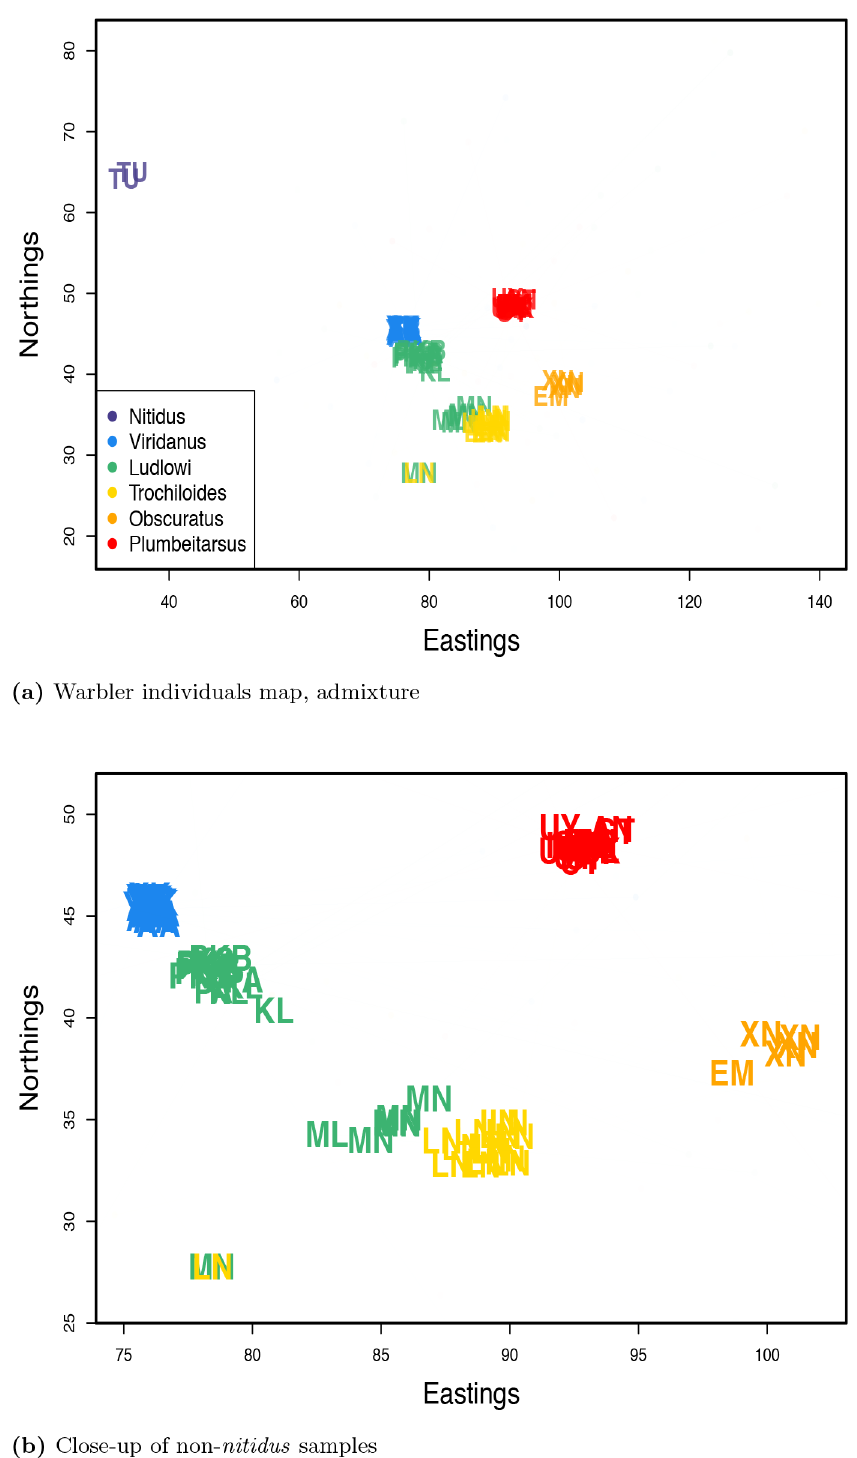
Fig 7. Inferred maps for warbler individuals with admixture inference. Individual labels are colored by subspecies as in Fig 5a. a) map inferred with admixture; b) close-up of all non- nitidus samples in the admixture